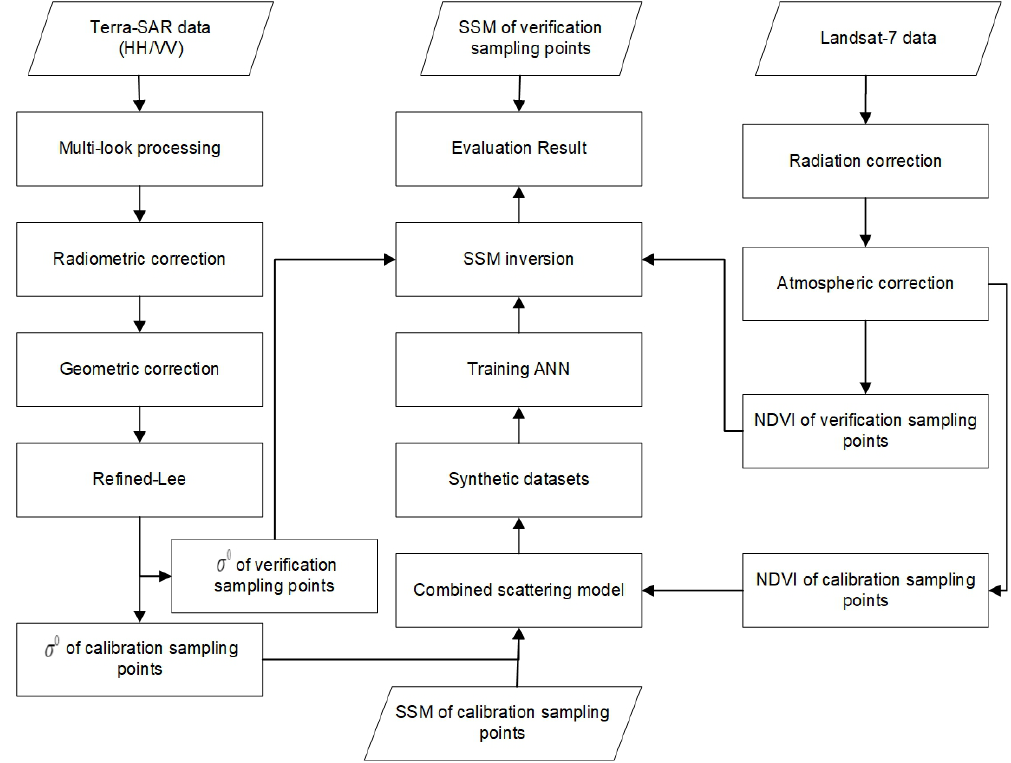
Figure 5. Overall workflow of the SSM retrieval